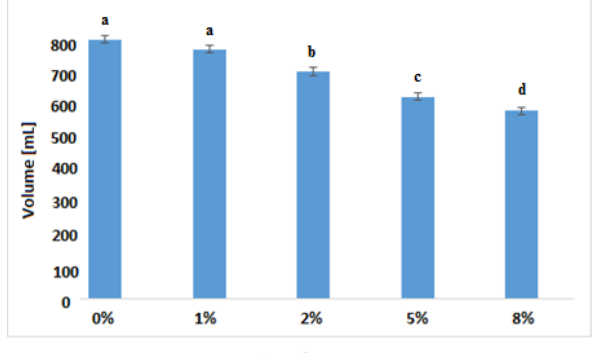
Figure 2: Influence of GSMP addition on volume of bread